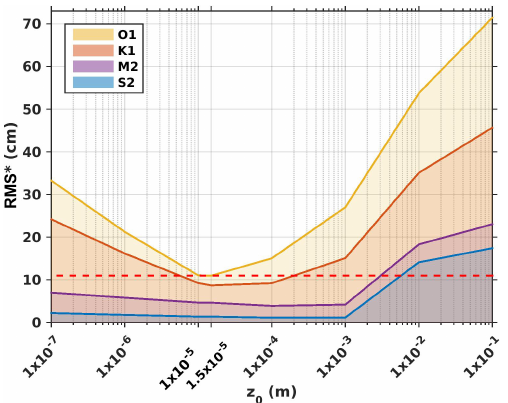
Figure 9. Model complex errors (Appendix; Eq. A2) relative to al- timetry along-track data for tests performed with varying the val- ues of the uniform drag coefficient C D over the domain (SET1). The space in between two lines corresponds to the error for each wave. The yellow line therefore corresponds to the cumulative er- ror for all four waves. The dashed red line corresponds to the smallest cumulative error, here equal to 11.50cm and obtained for C D = 0 . 9 × 10 − 3 m